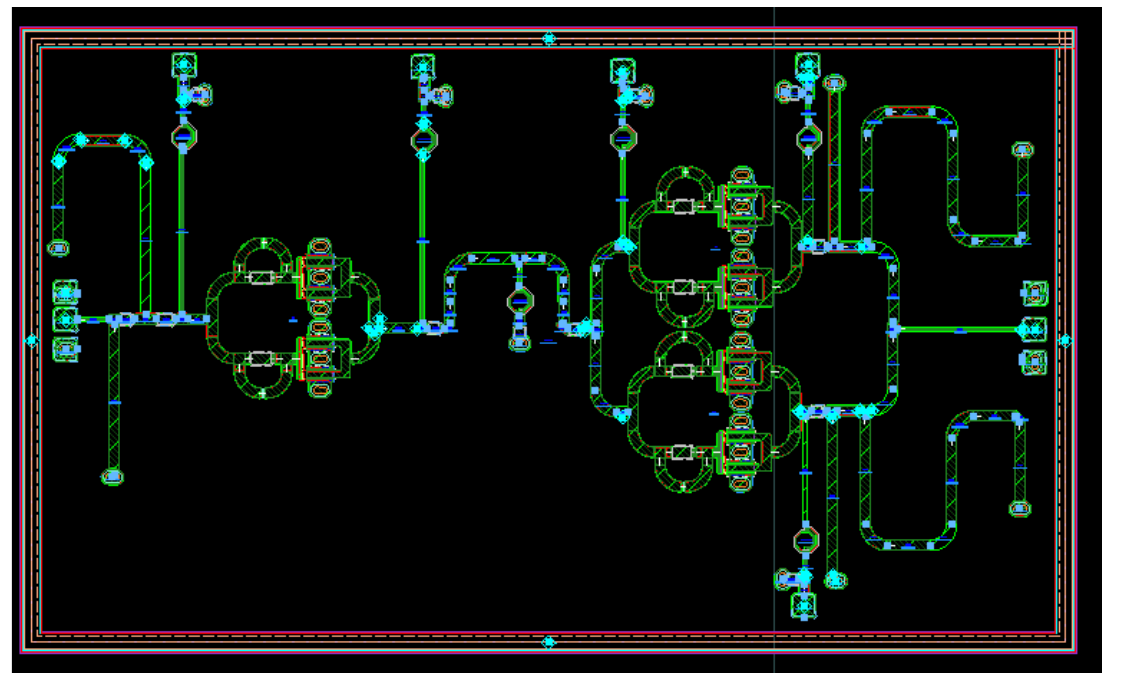
Figure 12. Schematic diagram of the MMIC PA layout.